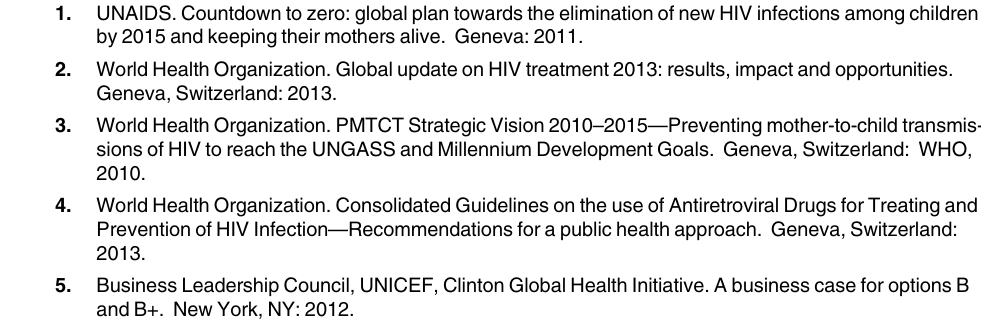
S1 Table. Results of mixed logit regression models with interaction terms with pregnancy status (pregnant vs. non-pregnant). S2 Table. Results of mixed logit regression models with interaction terms with ART status (Not currently on ART vs. on ART). S3 Table. Results of mixed logit regression models with interaction terms with current potential B+ clients (women pregnant or breastfeeding and not on ART or on ART during pregnancies only (pMTCT) vs. others). S4 Table. Results of mixed logit regression models with interaction terms with age less than 25 ( < 25 vs. 25+ years